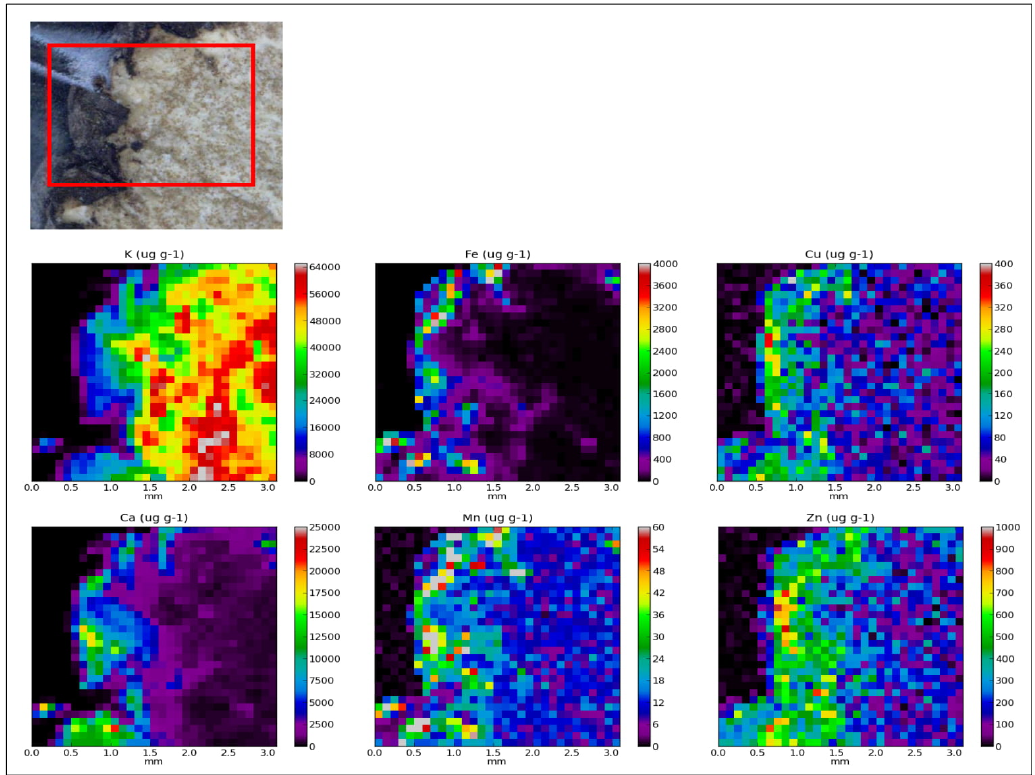
Figure 1. XRF quantitative analysis and Micro-XRF analysis of T. aestivum recorded using the BL6b, SLRI, Polychromatic Beam (Synchrotron Light Research Institute) with 100 µm lateral resolution.